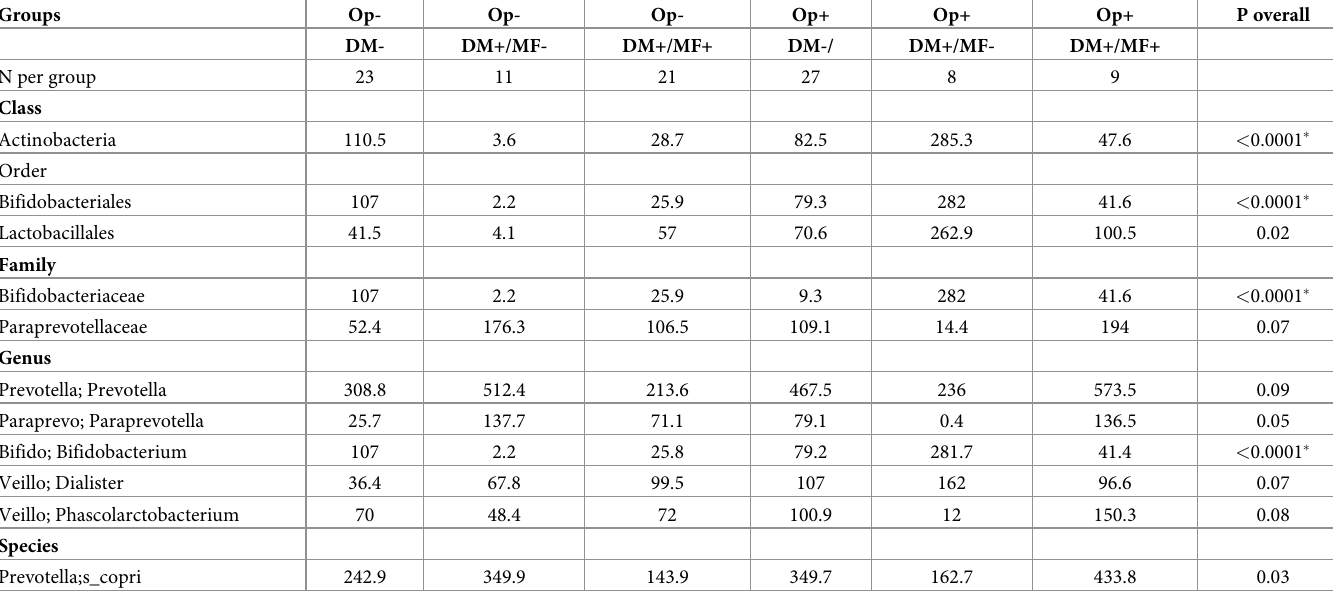
Table 3. Comparison of the gut microbiota among groups.